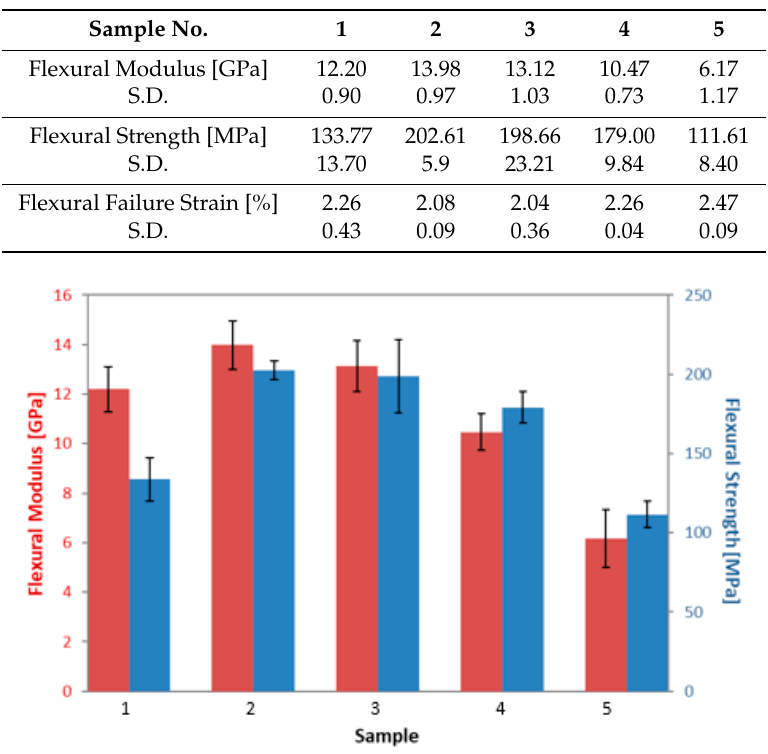
Figure 5. Flexural modulus and strength for all tested samples. Sample 1 showed lower properties due to voids in the matrix.